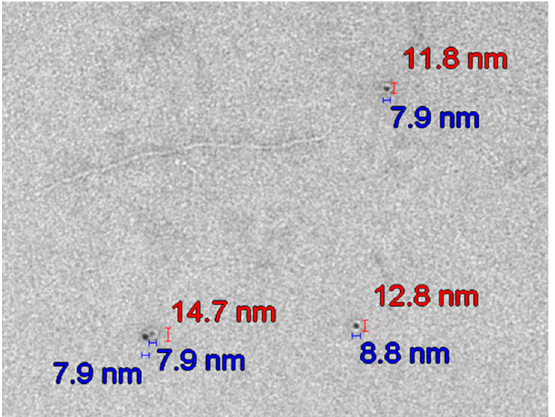
Figure 9. Typical transmission electron microscopy (TEM) micrograph of the size of TiO 2 nanoparticles in urine in study A. The particles are not ideally spherical and thus are characterised by two dimensions (red and blue abscissas in the micrograph).